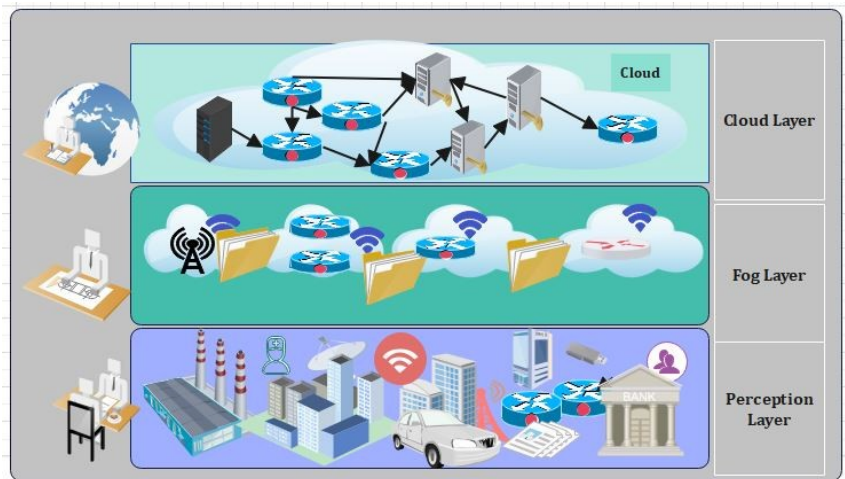
Figure 8. Proposed secure searchable encryption system using a DL-based intrusion detection system.